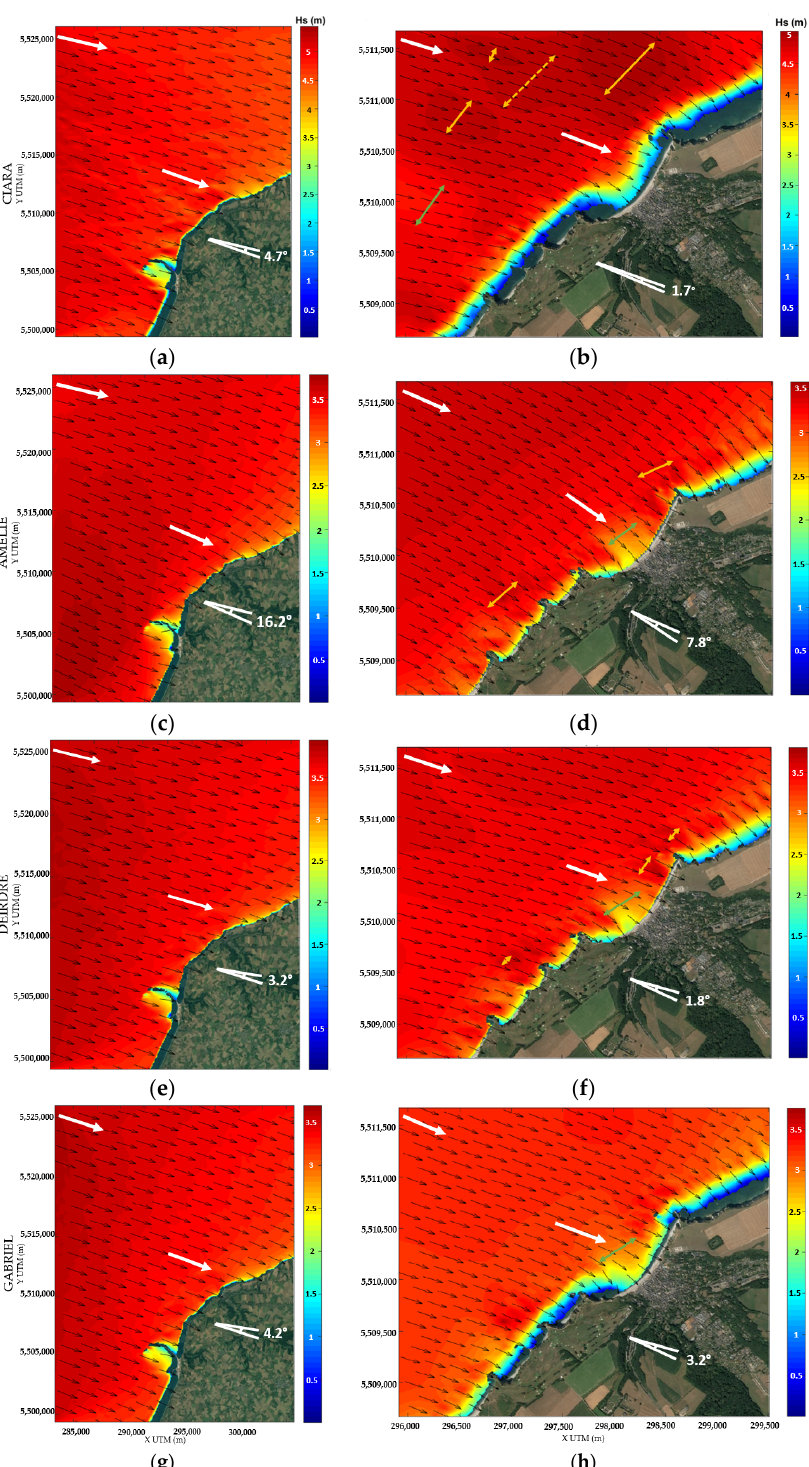
Figure 7. Distribution maps at the peak of the storm of H s and θ in the coarse grid ( a , c , e , g ) and nested grid ( b , d , f , h ) in Hautot-sur-Mer for Ciara (February 2020) ( a , b ), Amelie (November 2019) ( c , d ), Deirdre (December 2018) ( e , f ) and Gabriel (January 2019) ( g , h ) storms. White arrows show the refraction of waves when approaching to coast.